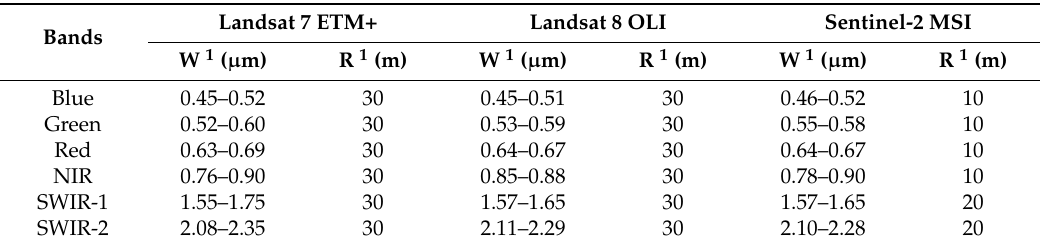
Figure 1. The location of the study area and the distribution of the ground truth points for accuracy assessment. The left part is the specific location of the study area in China, while the right part is a red, green, blue (RGB) composite image using the bands near-infrared (NIR), red, and green of Landsat 8 OLI and the distribution of water and non-water region of interests (ROIs). Table 1. Band comparison among Landsat 7 ETM+, Landsat 8 OLI, and Sentinel-2 MSI. Only selected bands used in this study were included here.